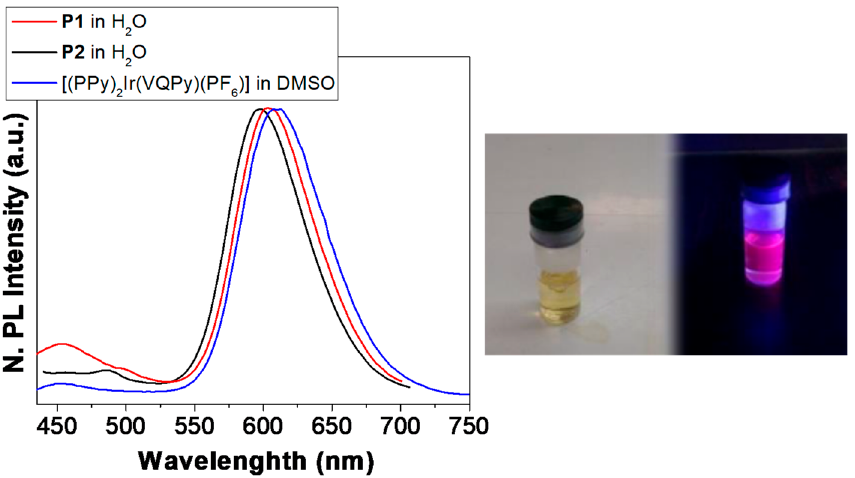
Figure 4. Photoluminescence spectra of the copolymers P1 and P2 in aqueous solution and of the monomer complex [(PPy) 2 Ir(VQPy)(PF 6 )] in DMSO, after excitation at 400 nm. The photographs in the right, show the aqueous solution of P1 in daylight (left photo) and under UV illumination at 365 nm (right photo).